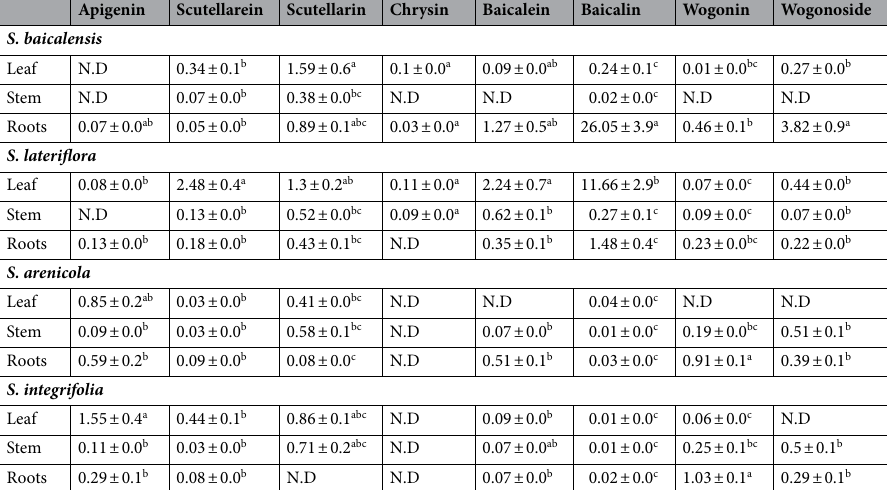
Table 2. Scutellaria species flavonoid profiles and localization within leaf, stem, and root tissues. Data are presented as means ± standard errors reported in mg g −1 of fresh weight. Means with different letters are significantly different (Tukey honestly significant difference (HSD), p < 0.05). Statistical analysis was performed for each metabolite across different species and tissue types. N.D. indicates levels below detectable